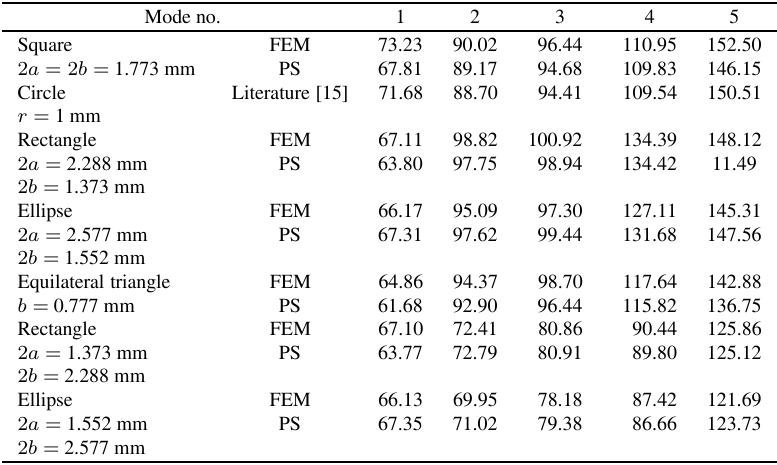
Table 5 First fi ve natural frequencies of hyperboloidal type spring with four cross-sectional shapes